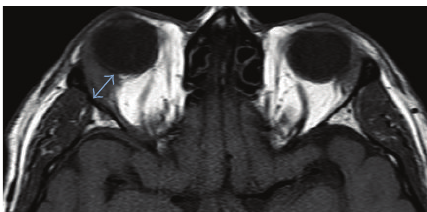
Figure 1: Contrast enhanced axial T2 weighted image showing enlarged right lacrimal gland (blue arrow) with soft tissue compro- mise suggestive of chronic